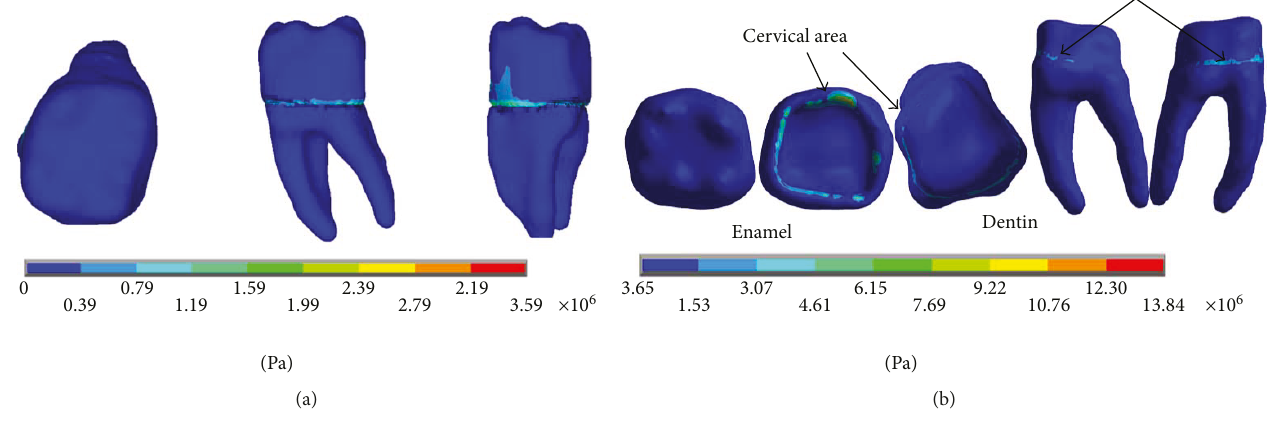
Figure 21: von Mises stress. (a) Contact. (b)